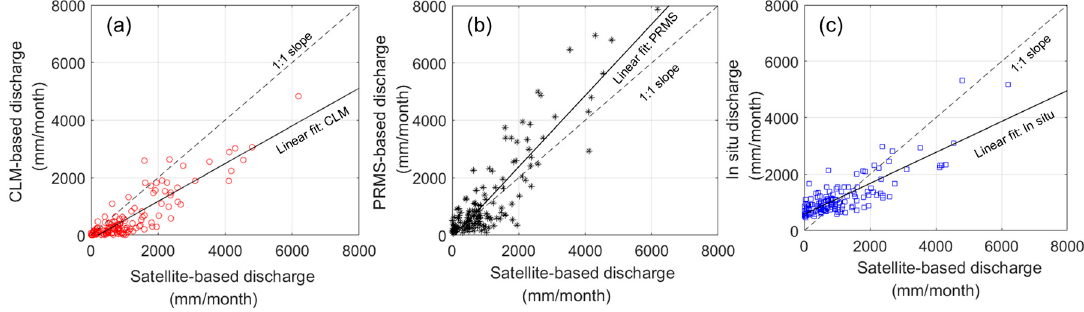
Figure 12. Scatter plots of discharge results, ( a ) Satellite-CLM; ( b ) Satellite-PRMS; ( c ) Satellite-in situ. Table 8. Statistical results of in situ discharge and model-based (CLM and Precipitation-Runoff Modeling System (PRMS)) discharge compared to satellite-based discharge.